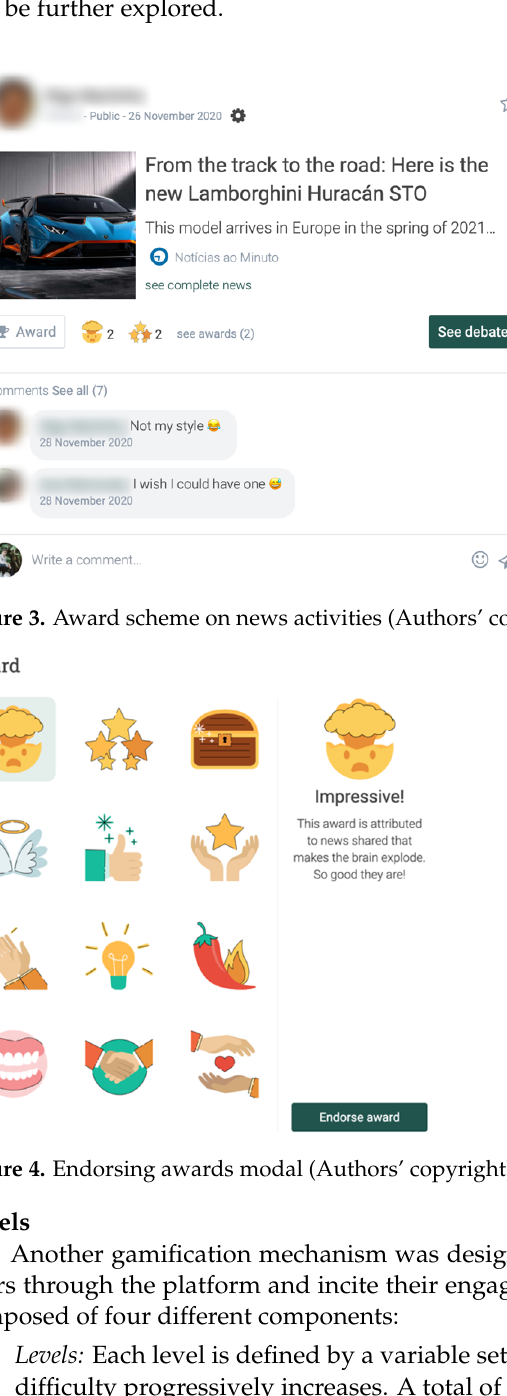
Figure 5. Initial modal with information about the various levels (Authors’ copyright). 2.